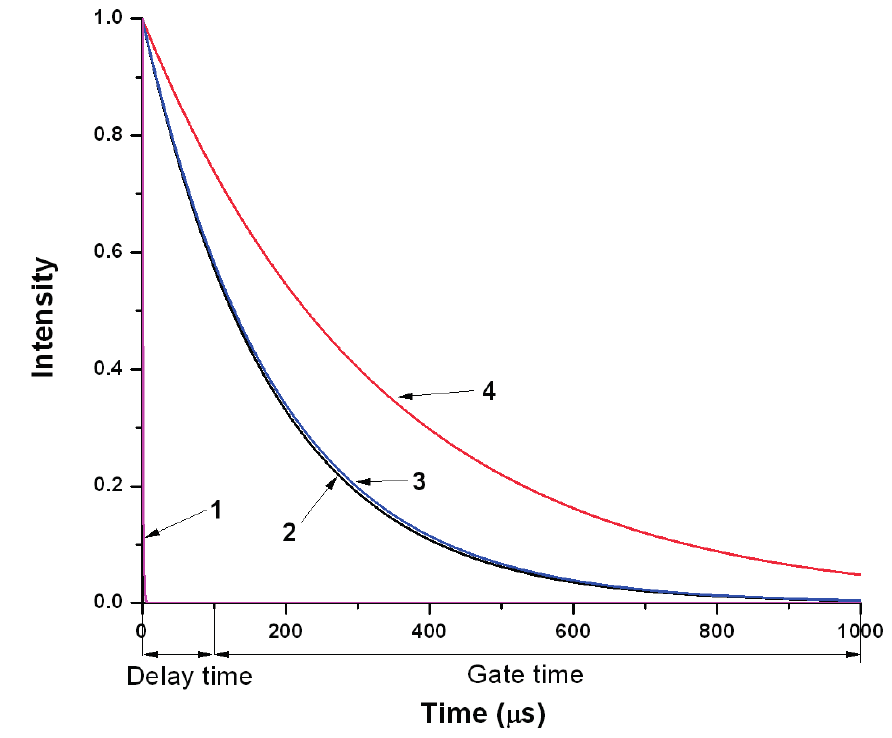
Figure 3. The principle of fluorescence spectroscopy with a time delay. (1) is the light flash; (2) is the fluorescence of the donor in the presence of acceptor; (3) is the sensitized fluorescence of acceptor; (4) is the fluorescence of the donor without the